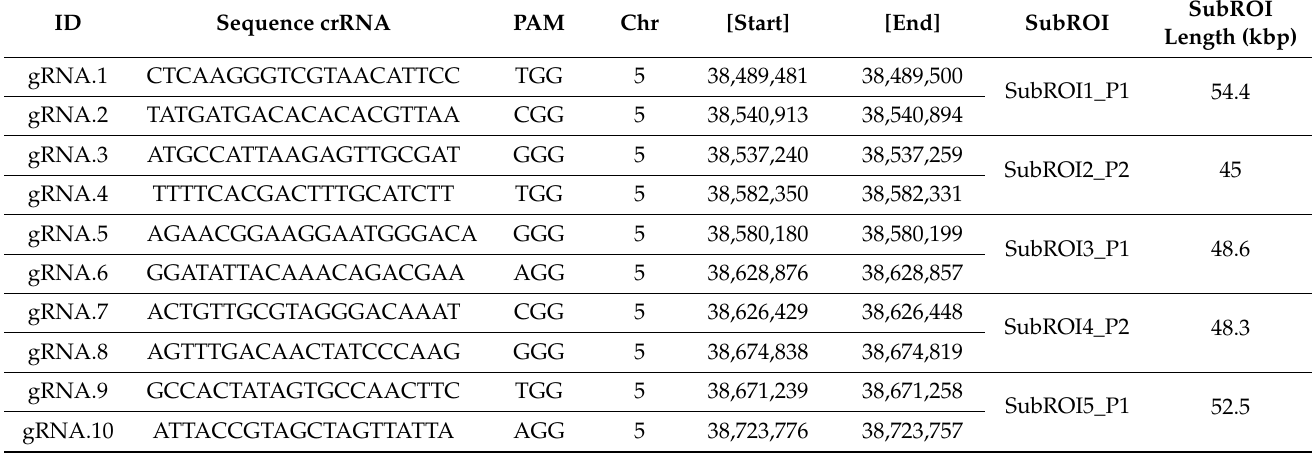
Table 1. CRISPR RNAs used in the study. The crRNA ID, sequence and position of the target in the P. vulgaris reference genome are shown, and The crRNAs are grouped according to the sub-ROI they cut and the reaction pool (P1 or P2).